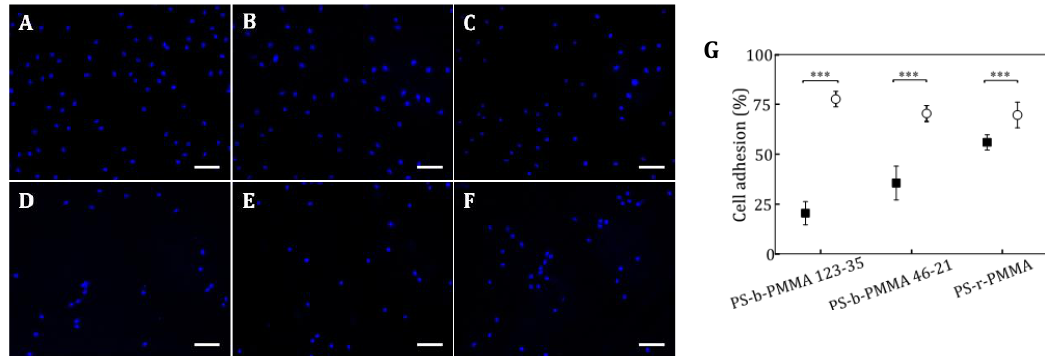
Figure 6. NIH/3T3 mouse embryonic fibroblast cells cultured on cRGDfK-NH 2 -PEG 3 modified surfaces for 4 h in starving medium. Arg-Gly-Asp (RGD) peptides were either covalently bound or physically adsorbed on diblock copolymer and random copolymer surfaces. ( A ) Fluorescent microscopy image of cell nuclei on a surface with covalently bound peptides on PS-b-PMMA 123-35 surfaces, ( B ) PS-b-PMMA 46-21, and ( C ) PS-r-PMMA. ( D ) Fluorescence microscopy image of cell nuclei on a surface with physical adsorbed peptides on PS-b-PMMA 123-35, ( E ) PS-b-PMMA 46-21, and ( F ) PS-r-PMMA. Staining: Hoechst for nuclei (blue); Scale bar 100 µm. ( G ) Percentage of cell adhered (with respect to the number of seeded cells) on covalently attached (hollow circles) or physically adsorbed (bold squares) RGD-ligands on top of the three different substrates. (*** denotes statistical significance level p < 0.001; error bars represent the standard error of the mean).